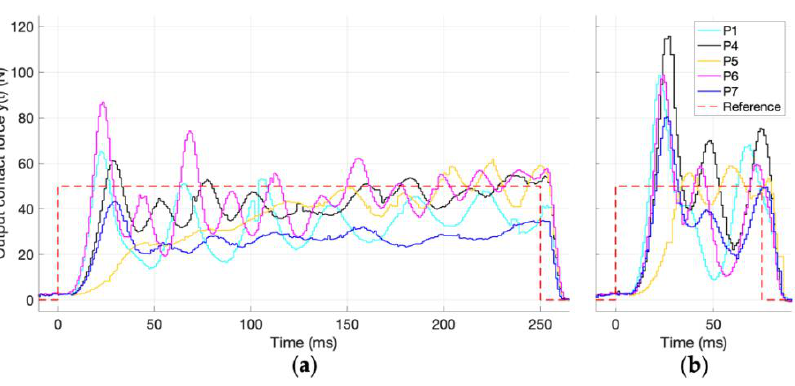
Table 5. HIL MPC tuned parameters and the resulting performance indices. The colors refer to the corresponding curves presented in Figures 5 and 6.